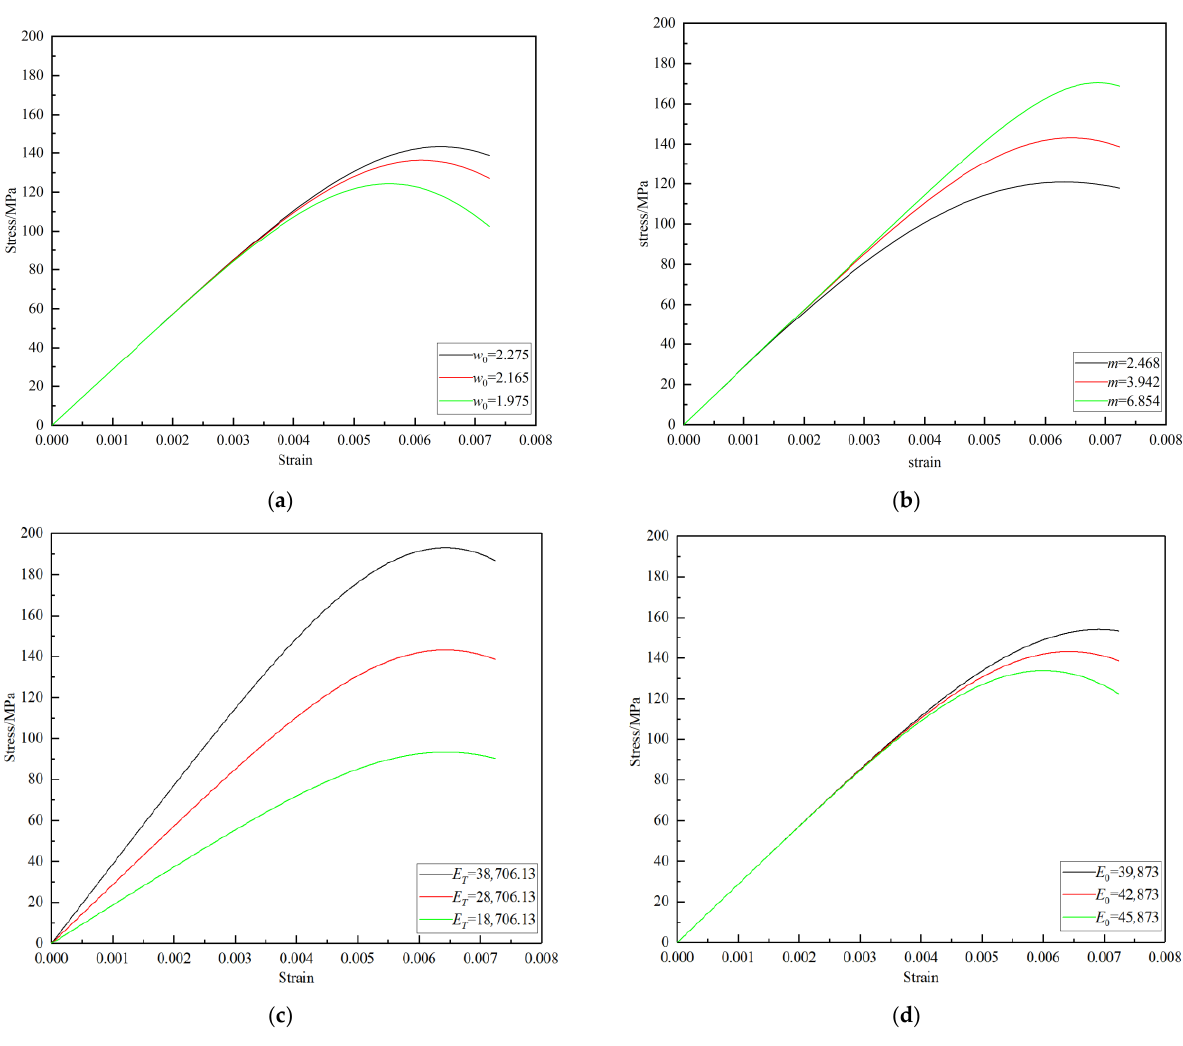
Figure 6. Influence of the model parameters on the stress–strain curves. ( a ) Effect of the parameter w_0 on the theoretical curve, ( b ) effect of the parameter m on the theoretical curve, ( c ) effect of the parameter 𝐸 𝑇 on the theoretical curve ( d ) effect of the parameter 𝐸 0 on the theoretical curve.